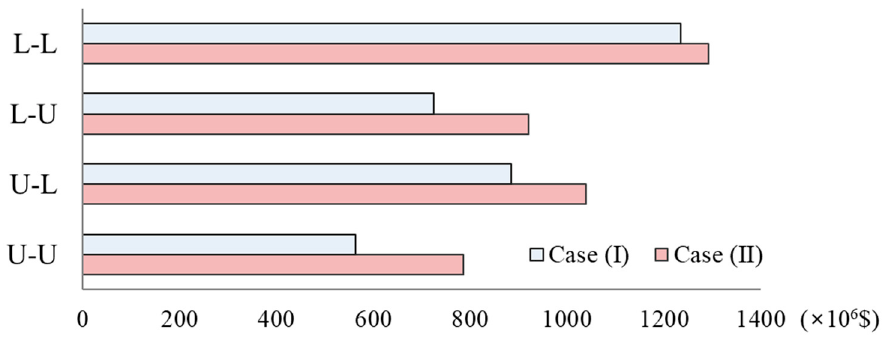
Figure 6. Regret costs of case (I) and (II) under di ff erent interval states. Note: “L-L”, “L-U”, “U-L”, “U-U” denote interval values of wind generation and EV is fixed to “lower and lower”, “lower and upper”, “upper and lower”, “upper and upper”